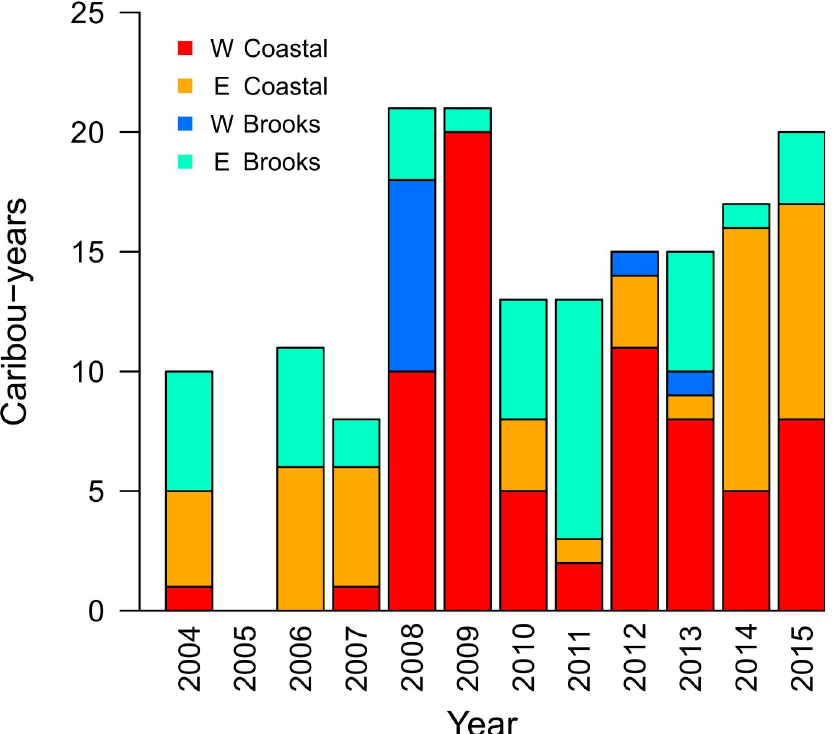
Fig 5. Wintering area use over time for the Teshekpuk Caribou Herd (TCH; n = 164). The x-axis depicts the start of the analysis-year (i.e., 2004 indicates the analysis-year stretching from 1 July 2004–30 June 2005). See Fig 1 for locations of the four wintering areas used by caribou of the